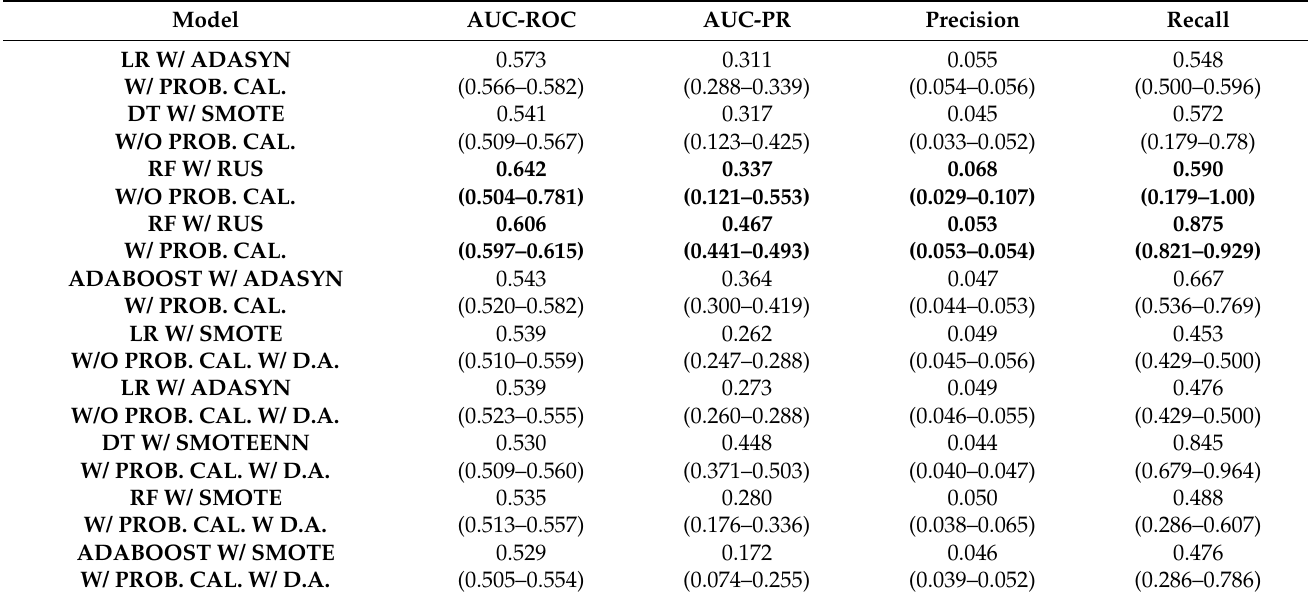
Table 3. Enhanced base learners performance (selected cases